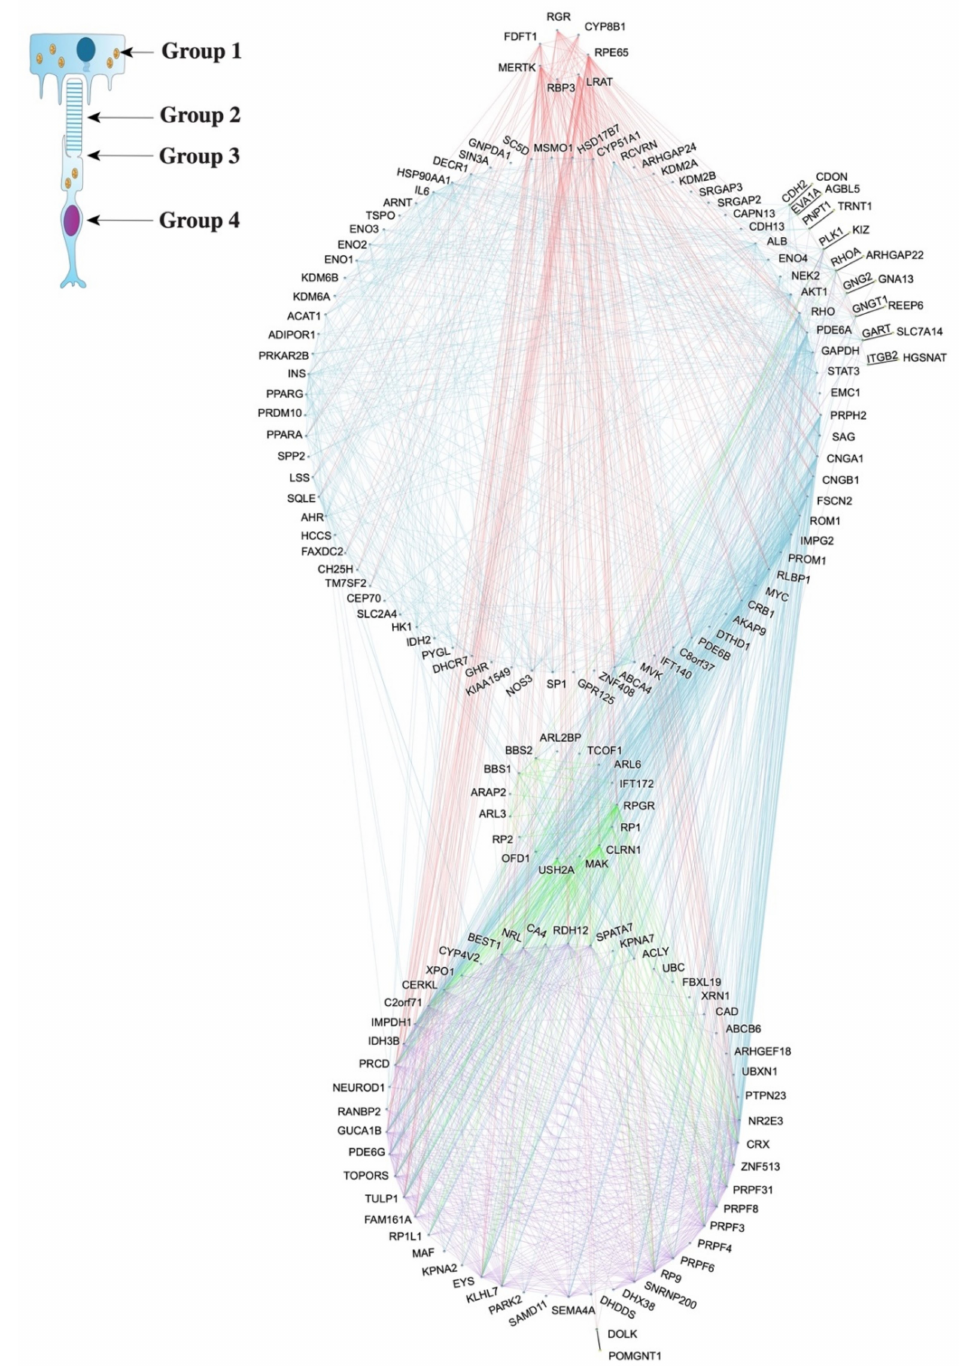
Figure 2. The Reorganized Complex Network of Genes Based on the Protein–Protein Interactions from the STRING v11 Database. This map has been through the gene classification and automation described in Appendix C. The genes are organized into four groups according to gene product localization and are annotated to show their connectivity. Group 1—retinal pigment epithelium (RPE); Group 2—OS; Group 3—connecting cilium; Group 4—nucleus. The intermediate genes are next to their respective disconnected gene. The color of an edge is determined based on the originating node for each interaction: red for Group 1, blue for Group 2, green for Group 3, and purple for Group